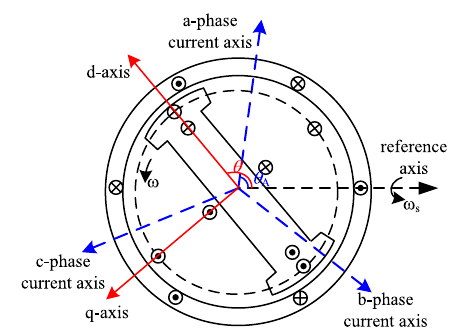
Fig. 4 Relative position of the dq-axis and the abc three-phase current axis in the synchronous